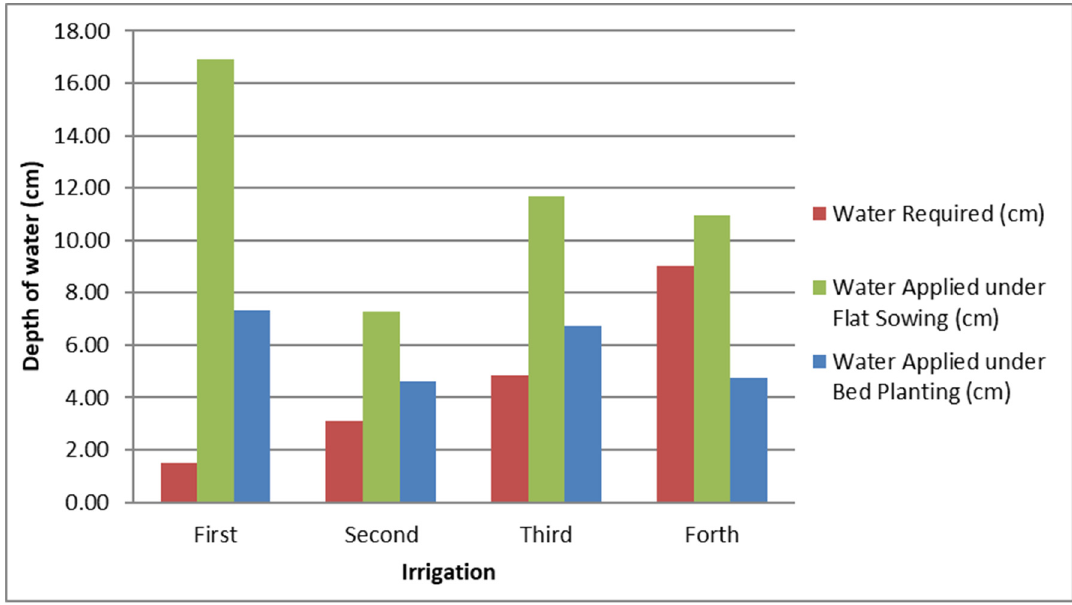
Figure 4. Comparison of irrigation requirements and applications [23].